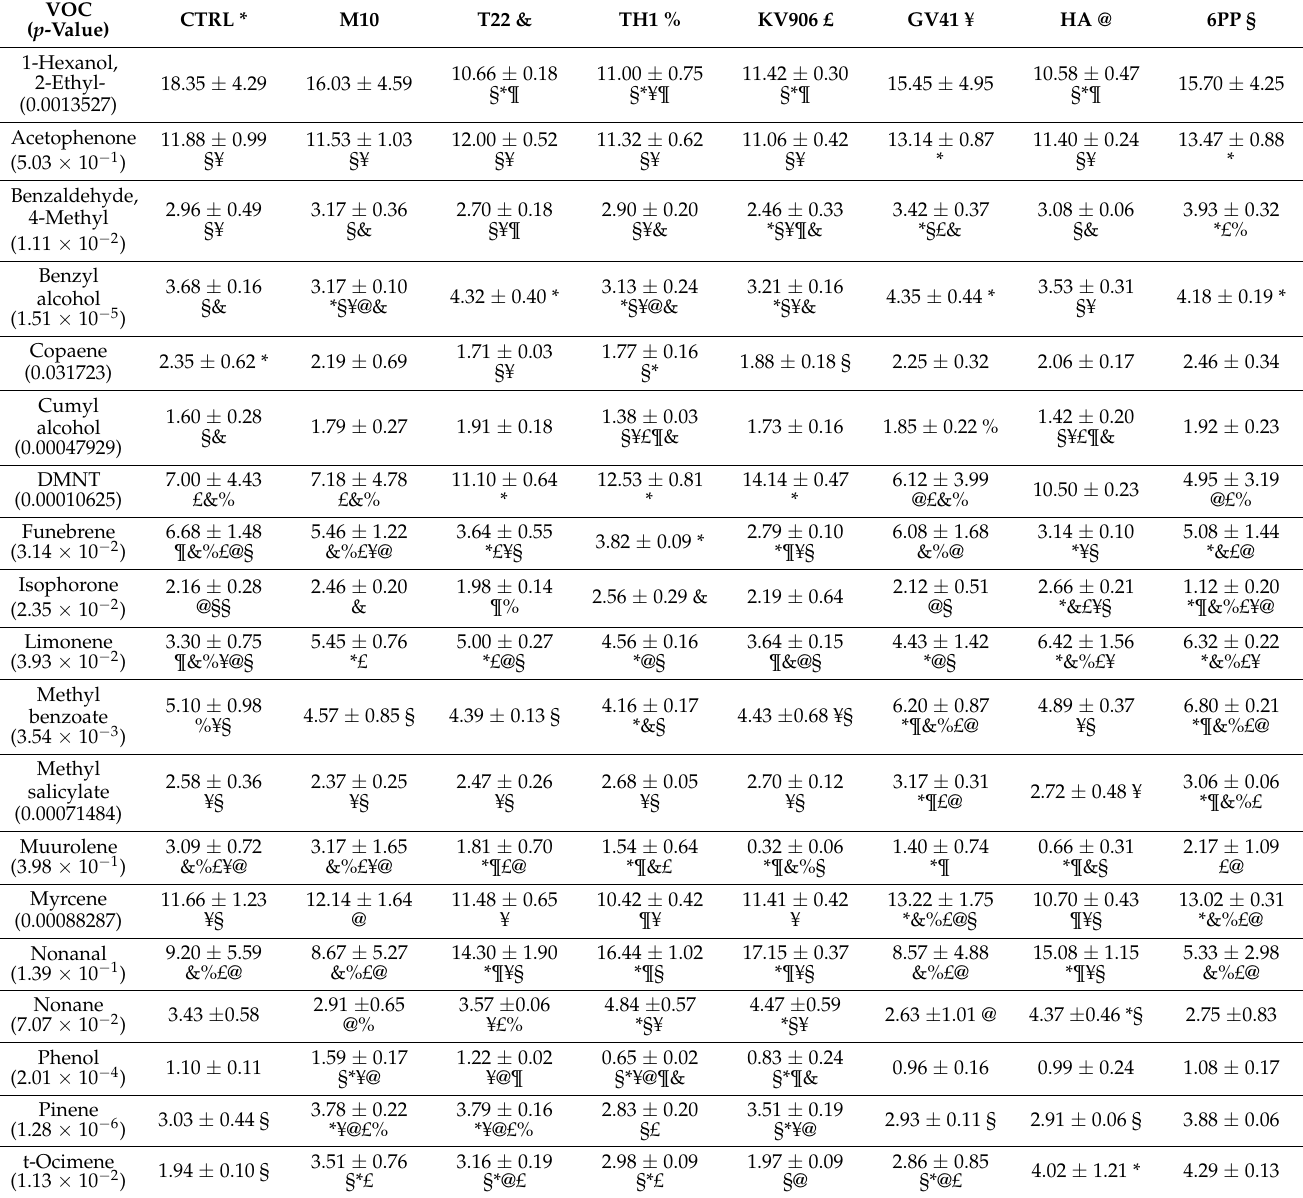
Table 3. Quantification of the VOCs produced by olive trees following the application of Trichoderma strains (M10, T22, TH1, KV906, GV41) or metabolites (HA, 6PP). Symbols in the tables indicate statistical differences among treatments as follows: * indicates a p -value < 0.05 compared to CTRL; § indicates a p -value < 0.05 compared to 6PP; ¥ indicates a p -value < 0.05 compared to GV41; ¶ indicates a p -value < 0.05 compared to M10; & indicates a p -value < 0.05 compared to T22; % indicates a p -value < 0.05 compared to TH1; £ indicates a p -value < 0.05 compared to KV906; @ indicates a p -value < 0.05 compared to HA. Each symbol has been also repeated under the treatment of reference in the first line of the